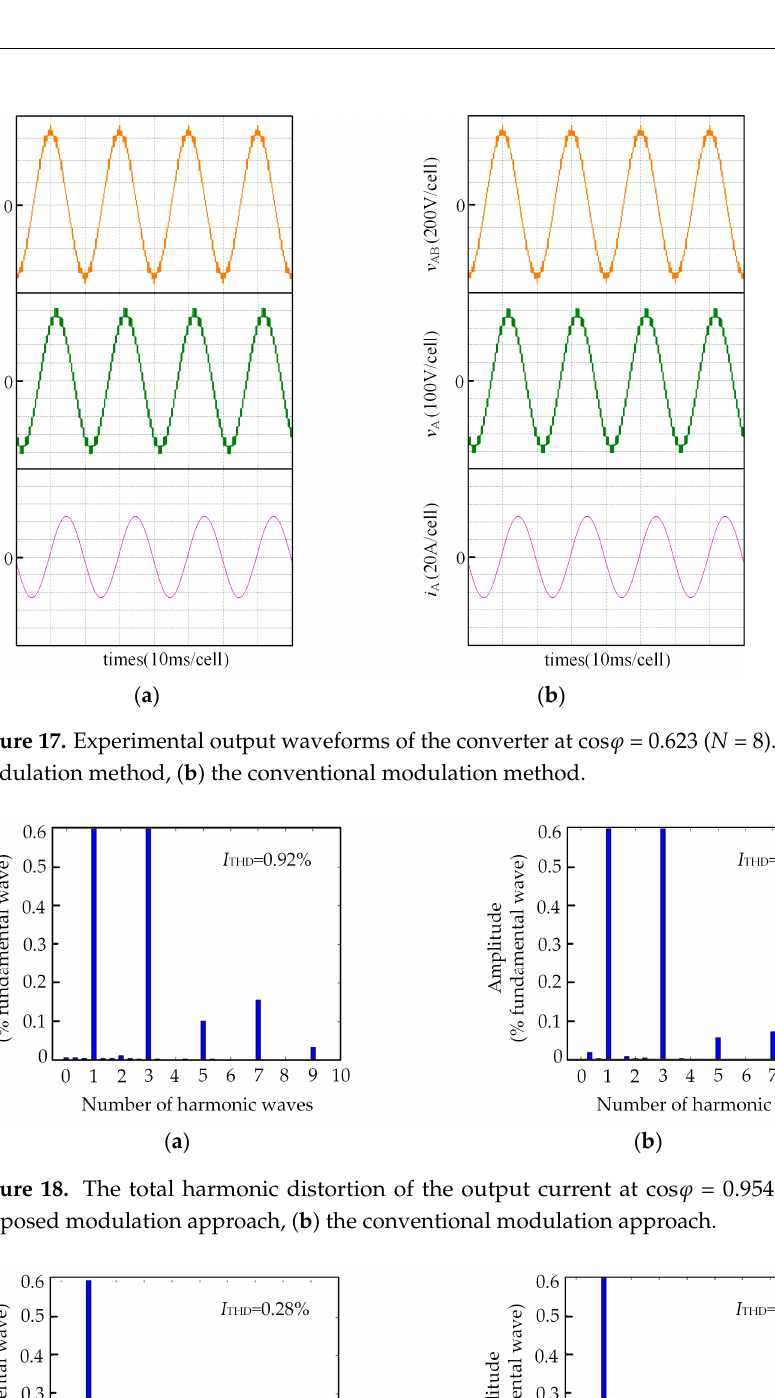
( b ) Figure 20. Experimental waveform of the circulating current fluctuation at cos φ = 0.954 ( N = 4). ( a ) The proposed modulation method, ( b ) the conventional modulation method. ( a ) ( b ) Figure 21. Experimental waveform of the circulating current fluctuation at cos φ = 0.623 ( N = 4). ( a ) The proposed modulation method, ( b ) the conventional modulation method. To demonstrate the similarity between the proposed modulation method and the conventional modulation method, the experimental output waveforms of the two meth- ods for different power factor conditions are shown in Figures 22 and 23. As can be seen,